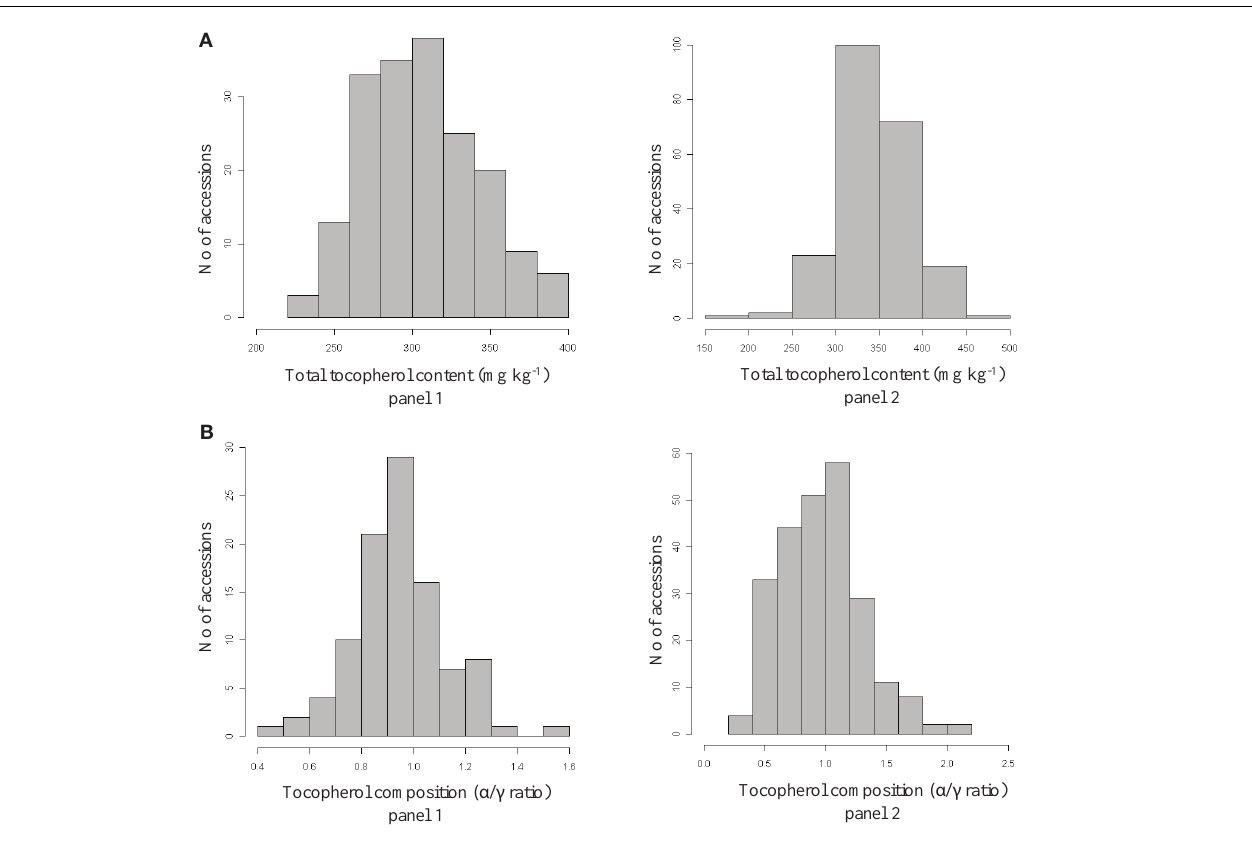
FIGURE 1 | Distribution of total tocopherol content (A) and composition (B) in two panels which consisted of 96 and 133 B. napus accessions, respectively. Plants were grown in the field at two different locations.Total tocopherol content is given as mgkg − 1 and the composition as α / γ ratio.